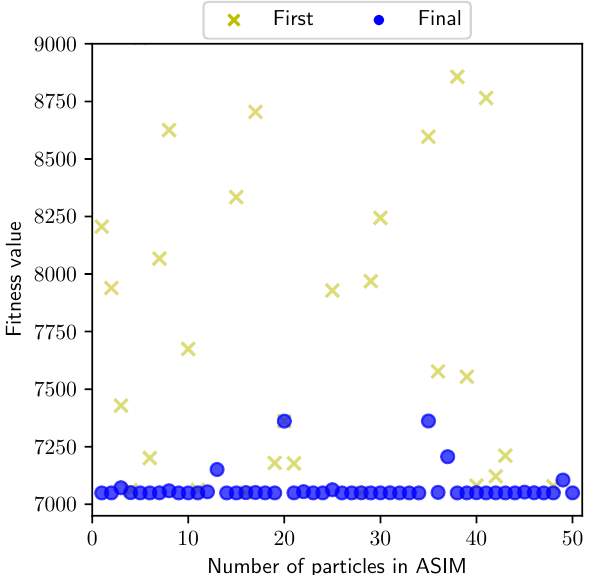
Figure 7. First and final output fitness values for G10 in a hybrid optimization